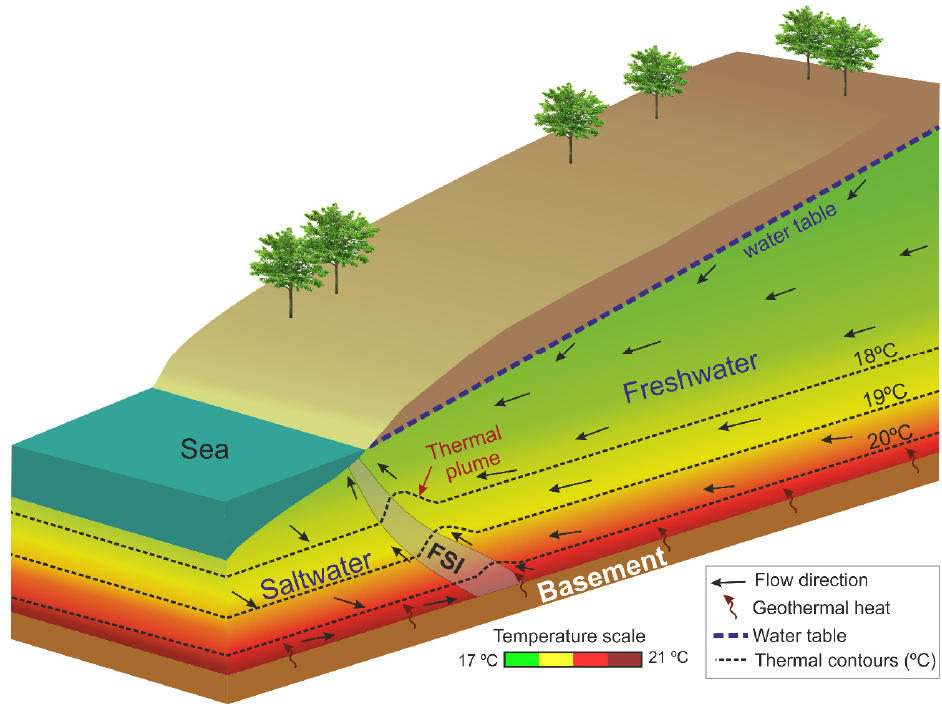
Figure 1. Simplified schematic diagram of temperature distribution of a coastal aquifer affected by the geothermal gradient. the geothermal